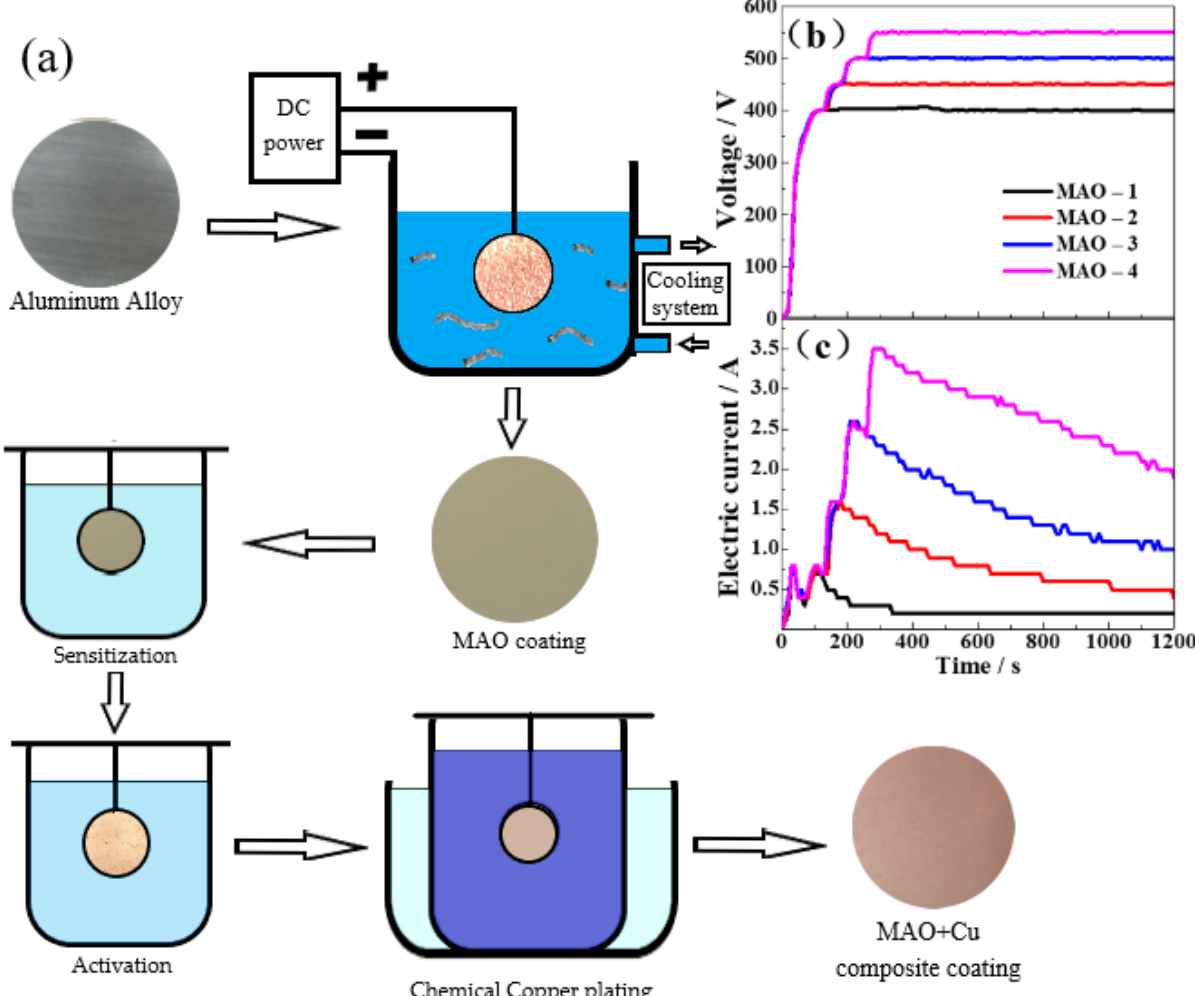
Figure 1. ( a ) Preparation flow chart of composite coating, variation trend of ( b ) voltage and ( c ) current in micro arc oxida- tion. Table 1. Condition parameters for MAO, pretreatment, and electroless copper plating onto the aluminum surface. Process